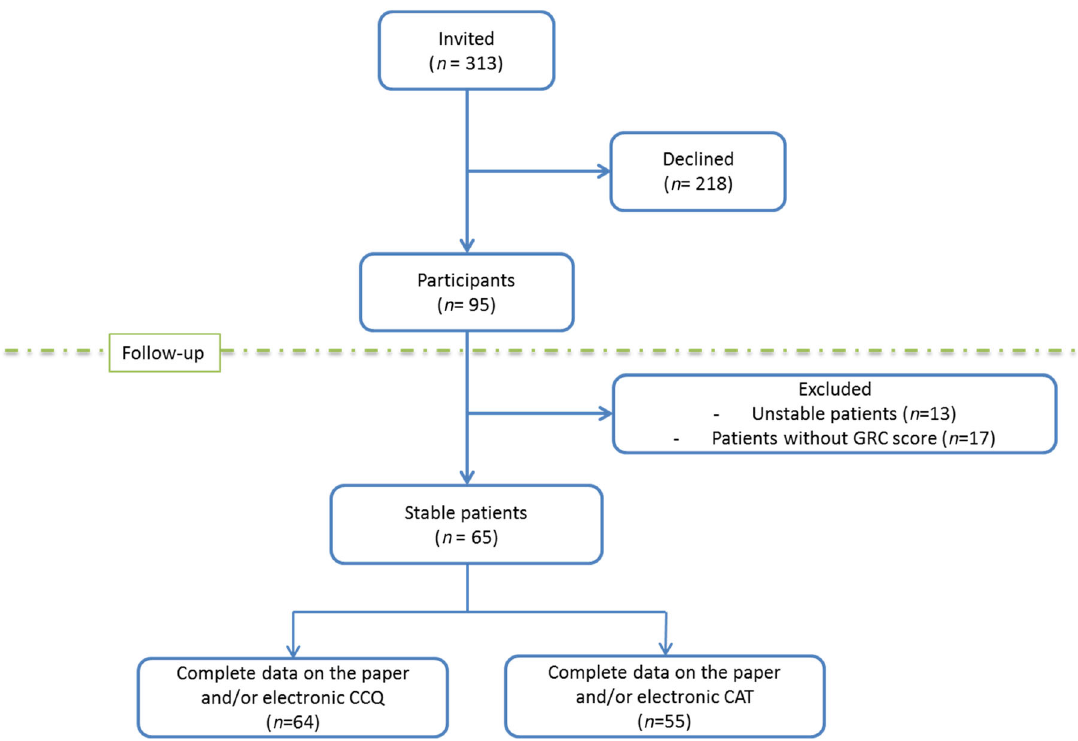
Fig. 1 Flowchart of the study. GRC global rating of change, CCQ clinical COPD questionnaire, CAT COPD assessment